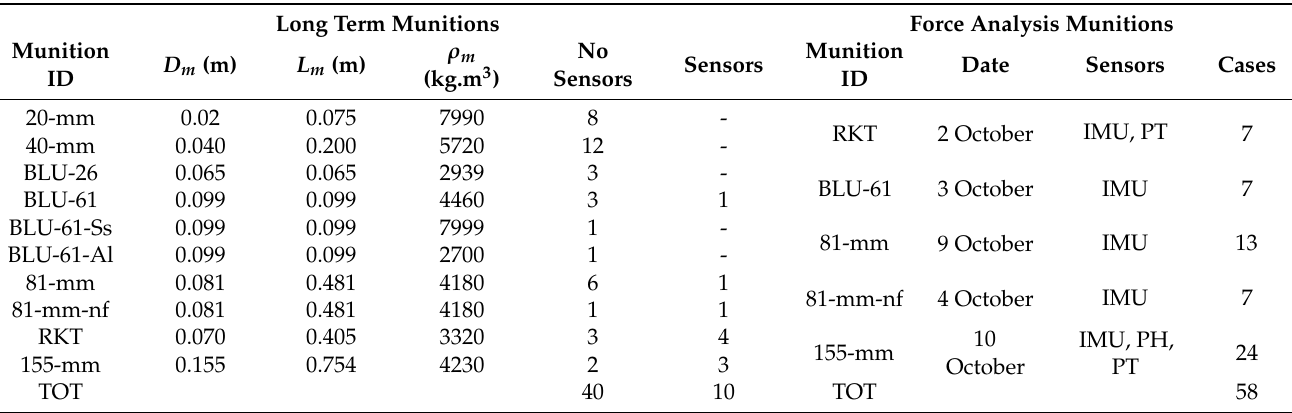
Table 6. Specifications of long term deployed munitions and force analysis munitions and physical munition